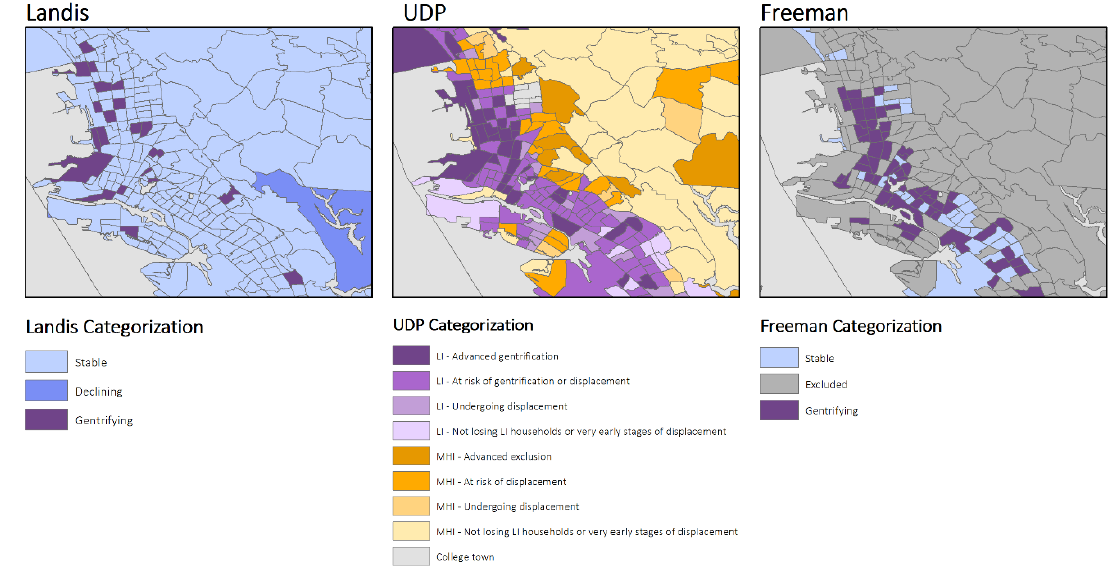
Figure 4. Spatial representation of Gentrification in Oakland, California using the three different measures, Bay Area Census Tracts, 2000–2013.